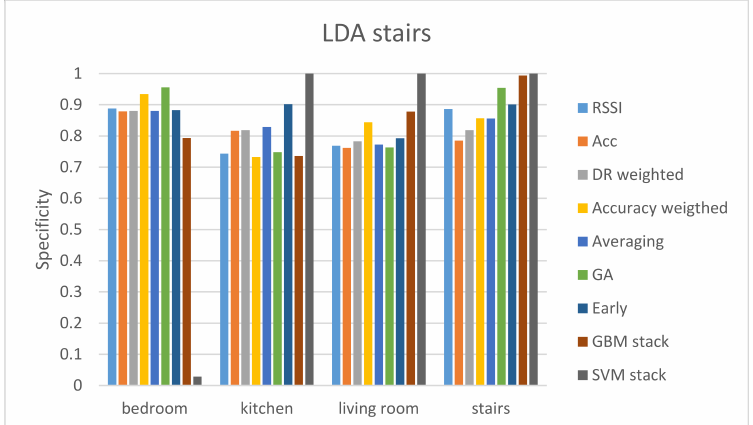
Figure 5. Specificity results of the LDA classifier for the